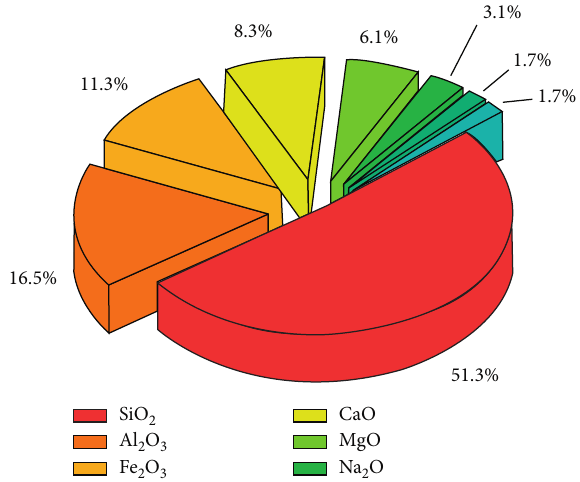
Figure 1: Chemical composition of basalt fiber